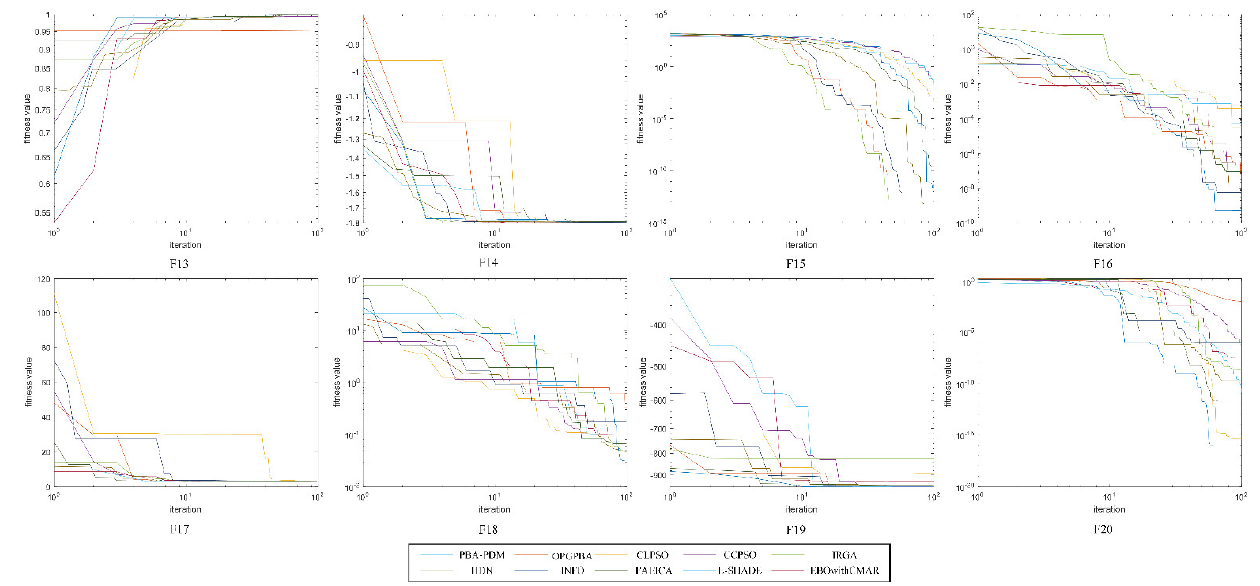
Figure 9. Convergence curves of the multimodal function.